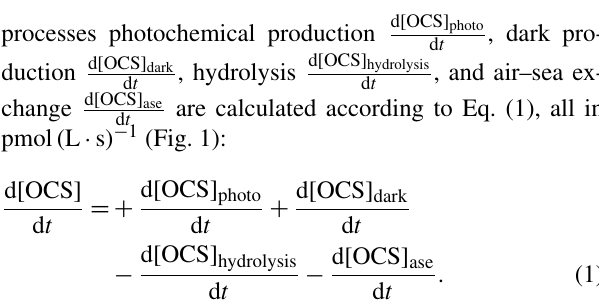
lantic transect, with an e -folding lifetime of ca. 10 d (Kettle et al.,